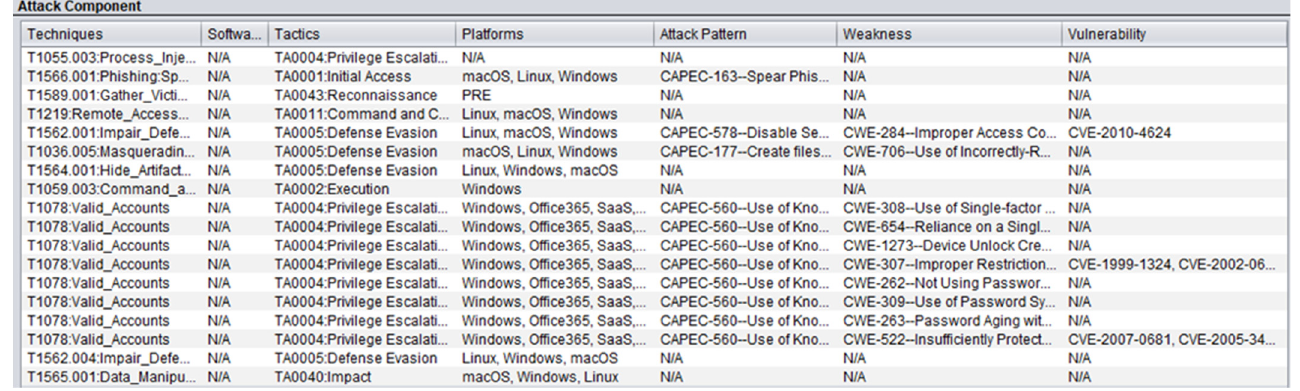
Figure 9. Attack scenario input screen.